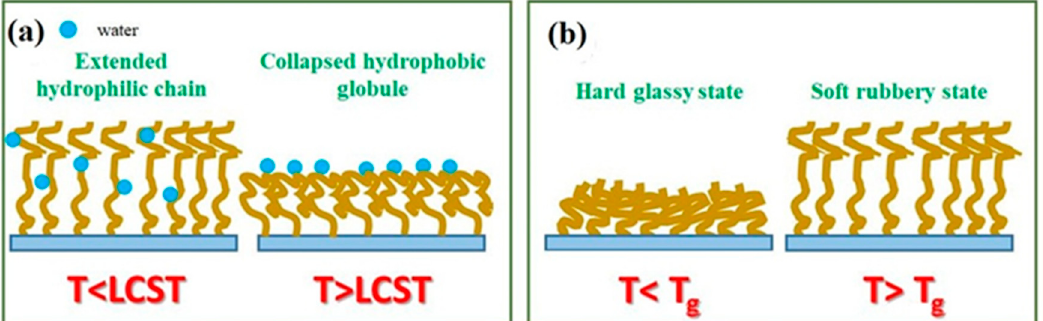
Figure 2. Schematic view of the transition of the TRPBCs from the extended hydrophilic chain to the collapsed hydrophobic globule caused by LCST ( a ) and the transition from the hard glassy state to the soft rubbery state (Tg) ( b ).